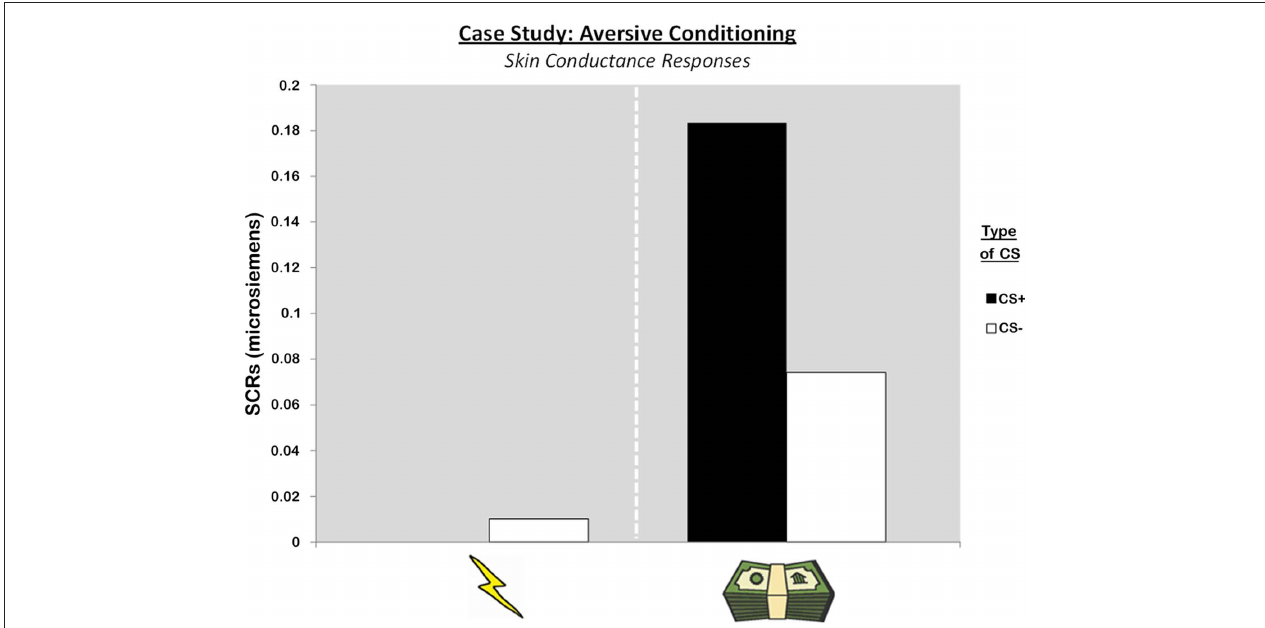
Figure 5 | Skin conductance responses during aversive conditioning sessions with primary and secondary reinforcers in one patient with bilateral amygdala